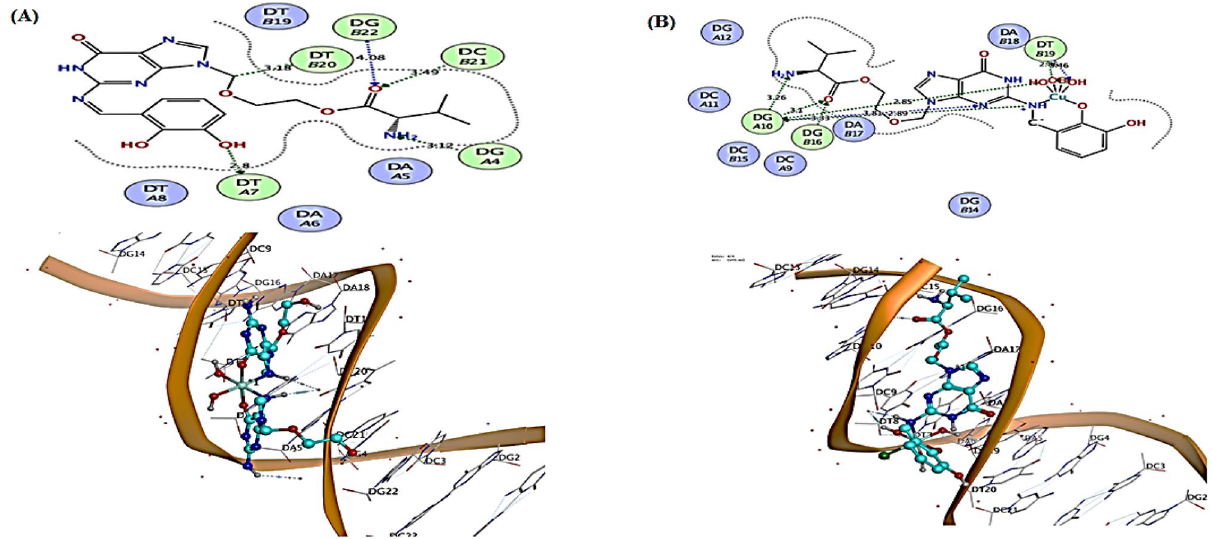
Figure 13. 2D & 3D diagrams showing interaction between the ligand, DBAPB, ( A ), and its Cu(II) complex 5 ( B ) with DNA by molecular